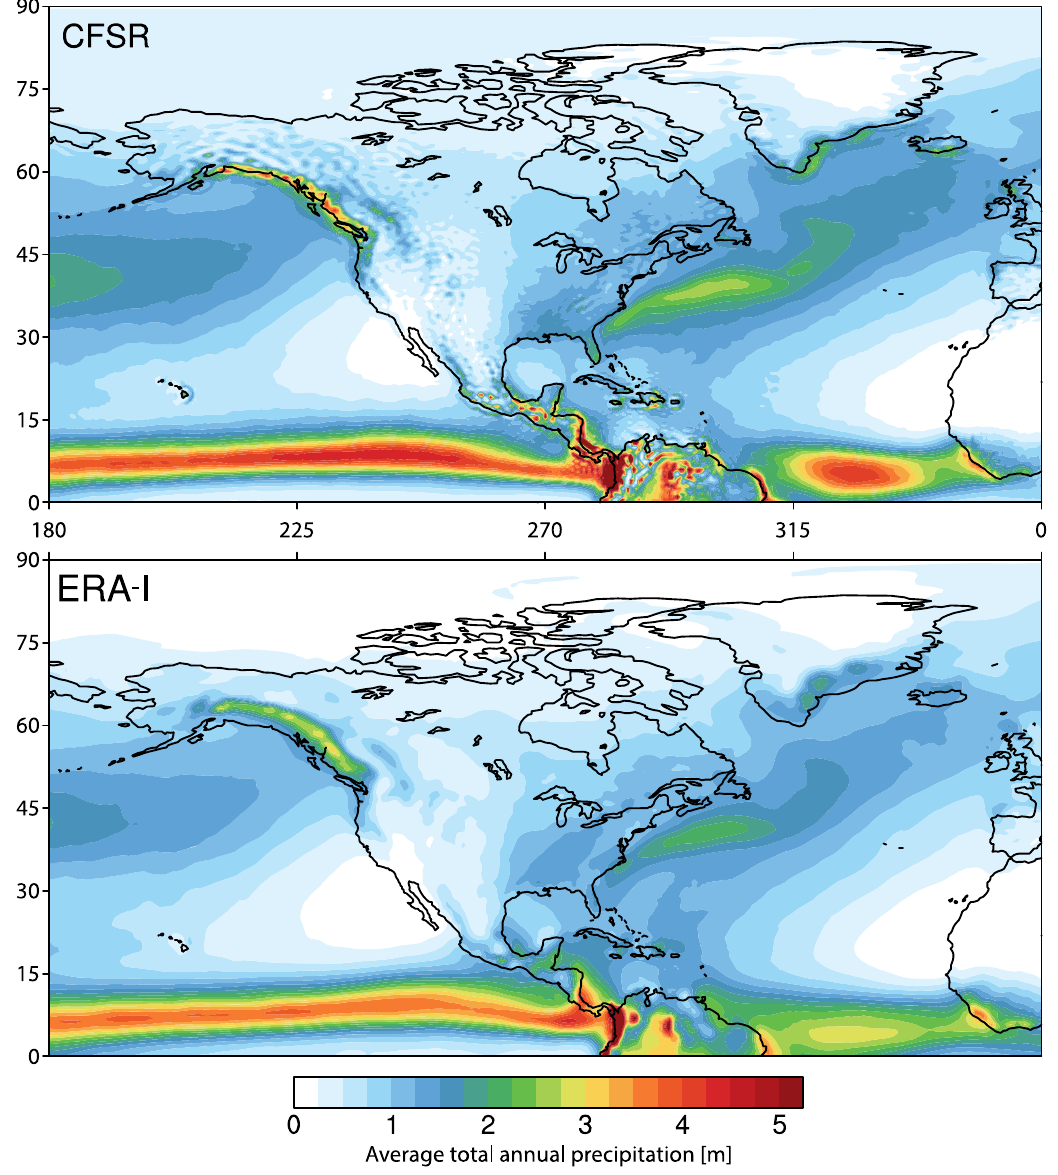
Figure 8. A comparison between CFSR ( top ) and ERA-I ( bottom ) 1981–2010 average annual precipitation totals. CFSR contains unrealistic, harmonic spherical artifacts on short and long-term averages whereas ERA-I (as well as JRA-55 and Modern-Era Retrospective Analysis for Research and Applications (MERRA)) displays a more spatially consistent output.